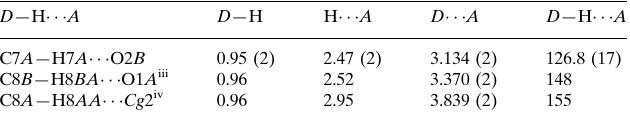
Hydrogen-bond geometry (A˚ , (cid:2)